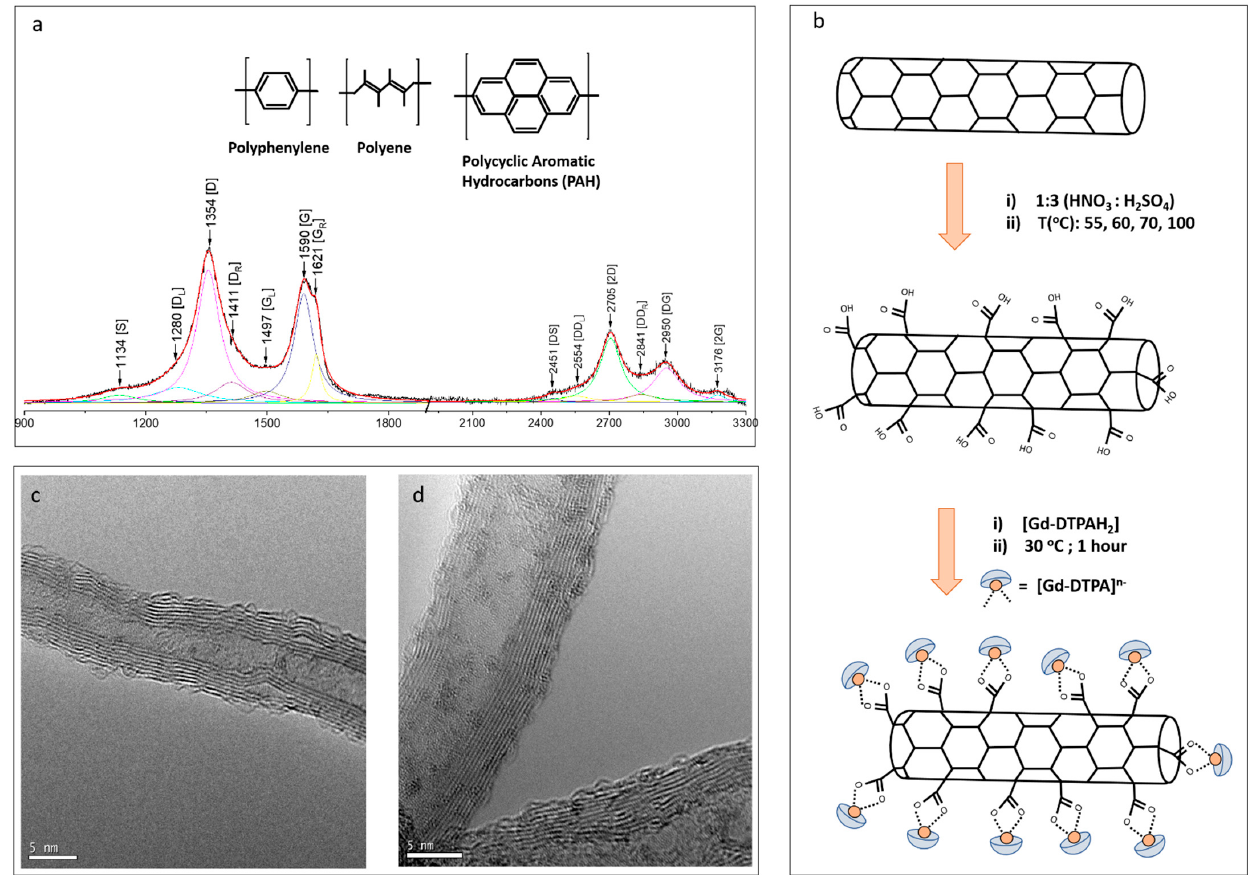
Figure 1. Raman spectroscopy is used to evaluate the effect of the mild oxidative functionalization technique. The D and G bands are deconvoluted to seven distinct Lorentz curves whose positions are anchored by the relevant second harmonic modes in the 2D region: ( a ) Following convention, we further distinguish between the minor modes based on their respective origin, either polyaromatic hydrocarbon type (PAH) or out of plane vibrations similar to polyene and polyacrylic structures. This allows for the tracking of the evolution of functionalization as a function of experimental parameters such as the oxidation time as well as reaction temperature. ( b ) Scheme for attaching a molecular magnet (Gd-DTPA) on to MWNTs through functional groups. ( c , d ) High resolution transmission electron microscopy (HR-TEM) image of pristine MWNT and CNT